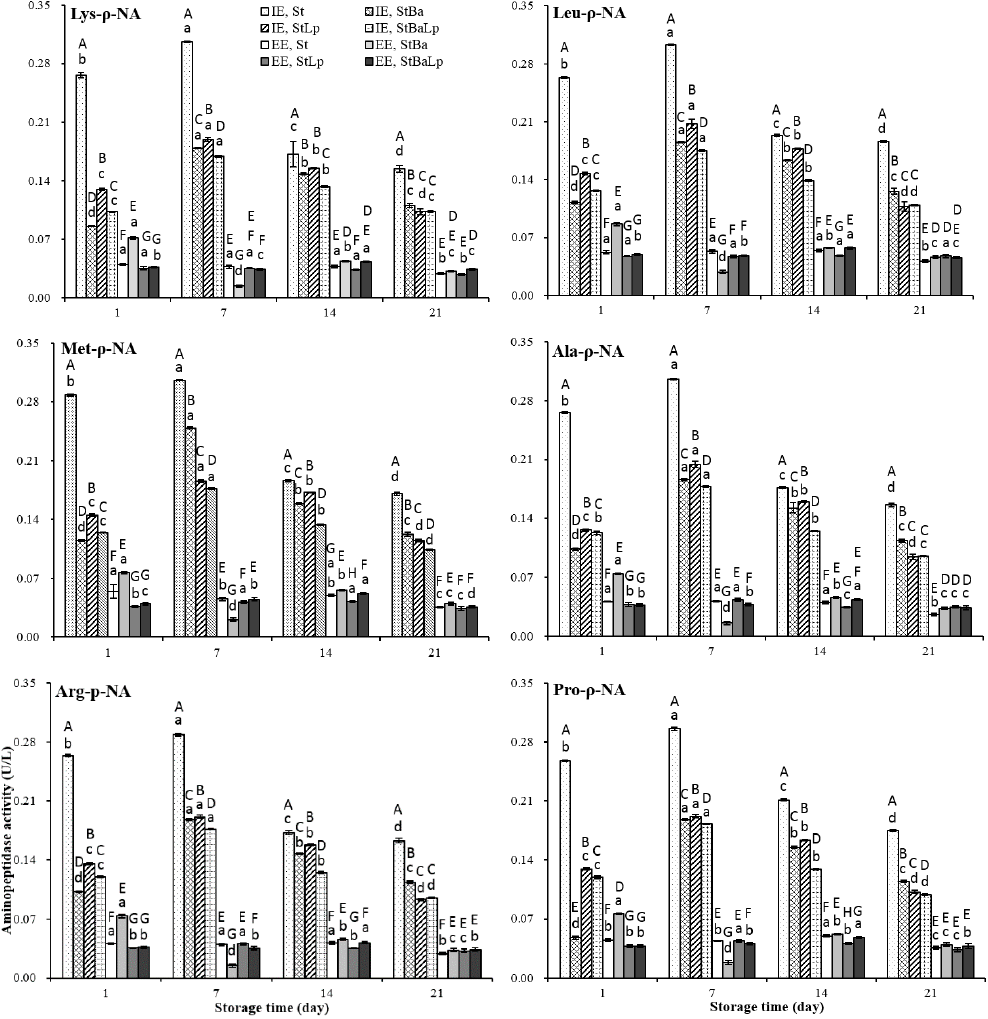
Figure 2. Changes in aminopeptidase activity (U/L) in fermented milk from different starter cultures during 21-day storage at 4 °C. Note: Data are means ± standard deviation ( n = 3). Bars marked with different lower-case letters indicate significant differences among days of storage for the same batch of fermented milks ( p < 0.05); Bars marked with different upper-case letters indicate significant difference among starter cultures within the same period ( p < 0.05).